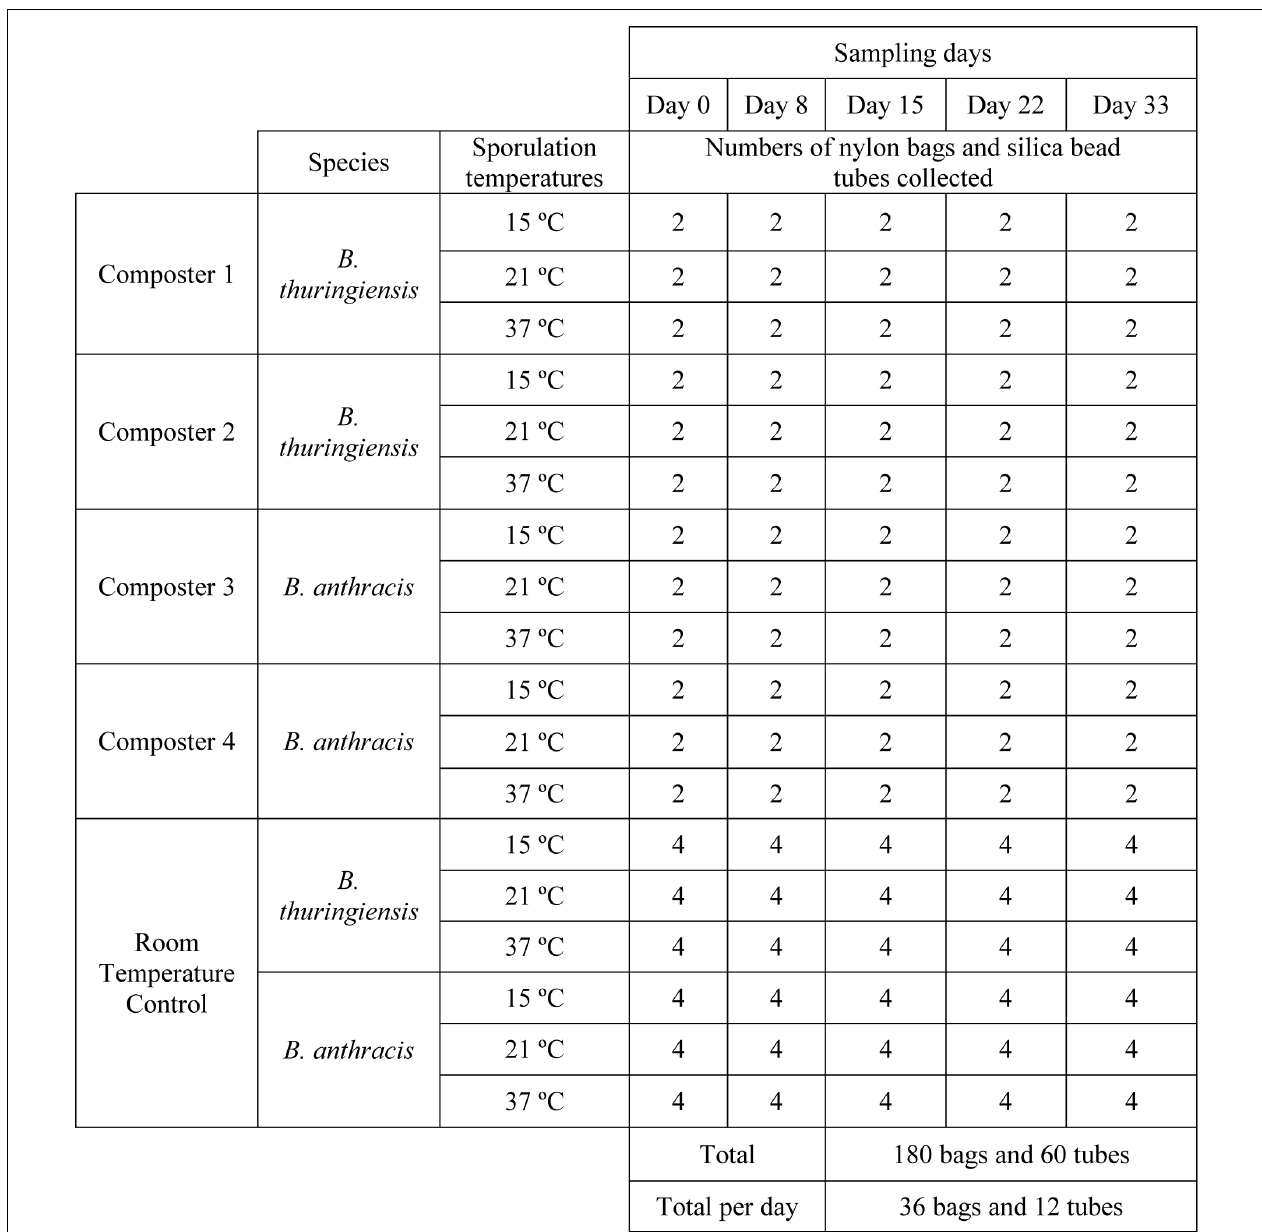
FIGURE 1 | Schematic representation of the experimental design and numbers of Bacillus thuringiensis and B. anthracis samples collected during composting under biocontainment conditions. Duplicated composters were used for each Bacillus species sporulated at 15, 21, and 37 ◦ C. Manure was inoculated with spore suspensions and then sealed in nylon bags prior to placing into composters. For a room temperature control, autoclaved silica beads were inoculated to achieve the same spore concentration as for inoculation of manure and then sealed in Falcon tubes. Two replicate nylon bags for each sporulation temperature and species were collected from the composters at days 0, 8, 15, 22, and 33. Room temperature controls of duplicate nylon bags and tubes (i.e., total number = 4) for each sporulation temperature and species were collected on the same sampling